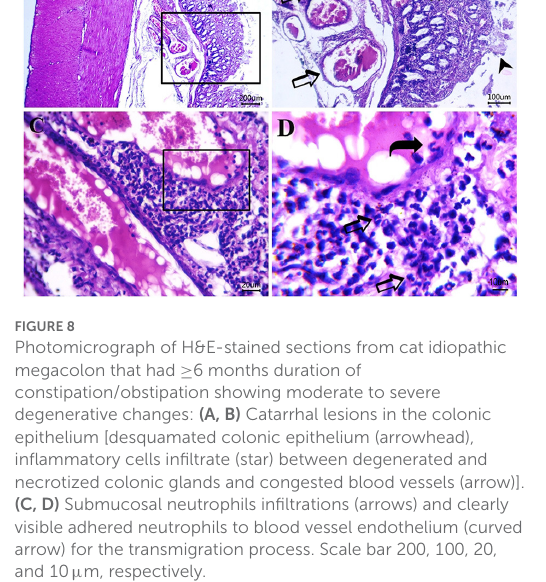
diameter and MCD/L5 length ratio were 21.3 mm (SD: